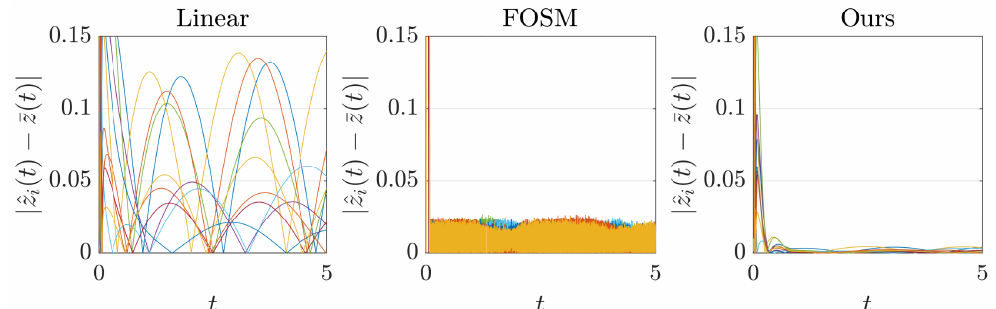
Figure 8. Comparison of consensus error with linear protocol, FOSM, and our protocol, under full communication ( ∆ = 10 − 4 , ε = 0). With the linear protocol, there exists a permanent steady-state error, which is higher than for the other protocols. Both the FOSM and our protocol can eliminate the error in a continuous-time implementation, but in the discretized setup our method improves the error caused by chattering with respect to the FOSM protocol.